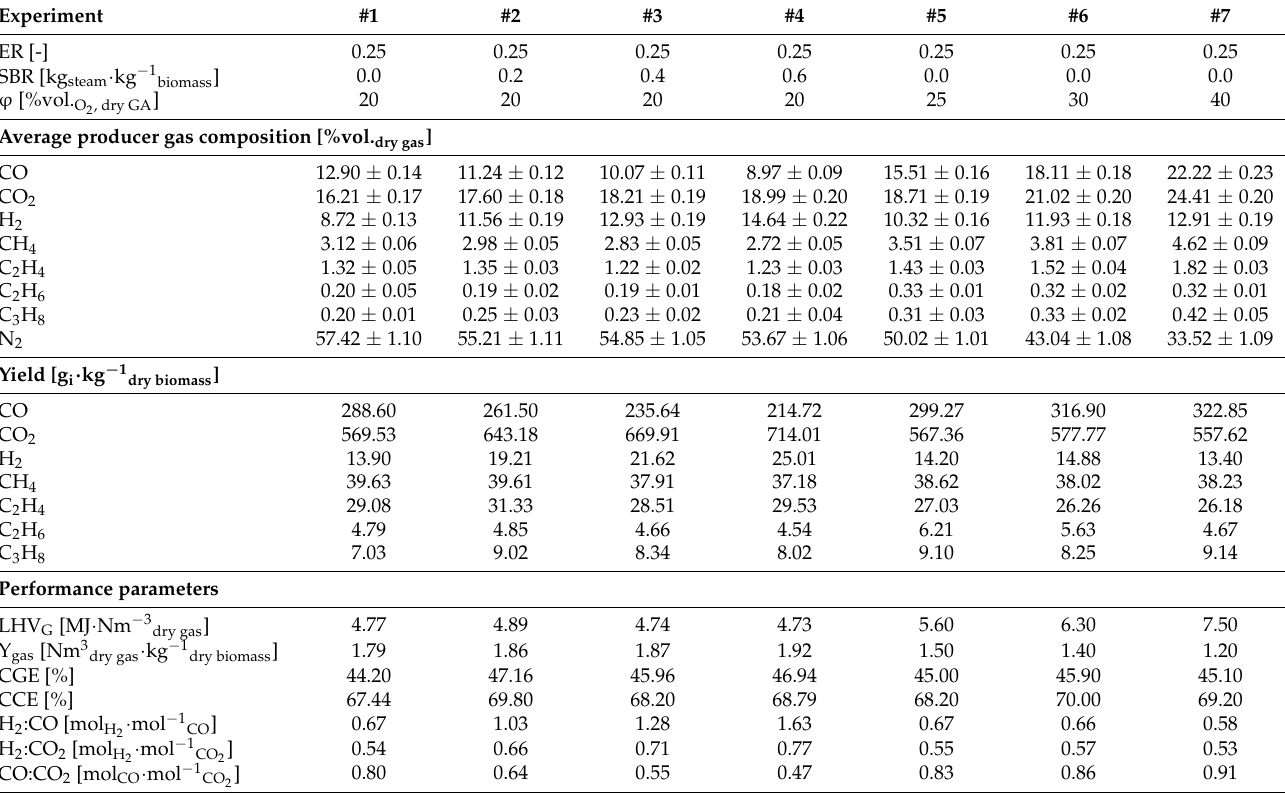
Table 4. Summary of results obtained in this